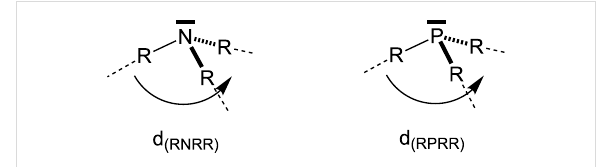
Figure 10: Scheme for the angle d(RXRR) measurements. Table 11: RXRR angle, Δ HOMO-LUMO and character of the lone pair of Lewis